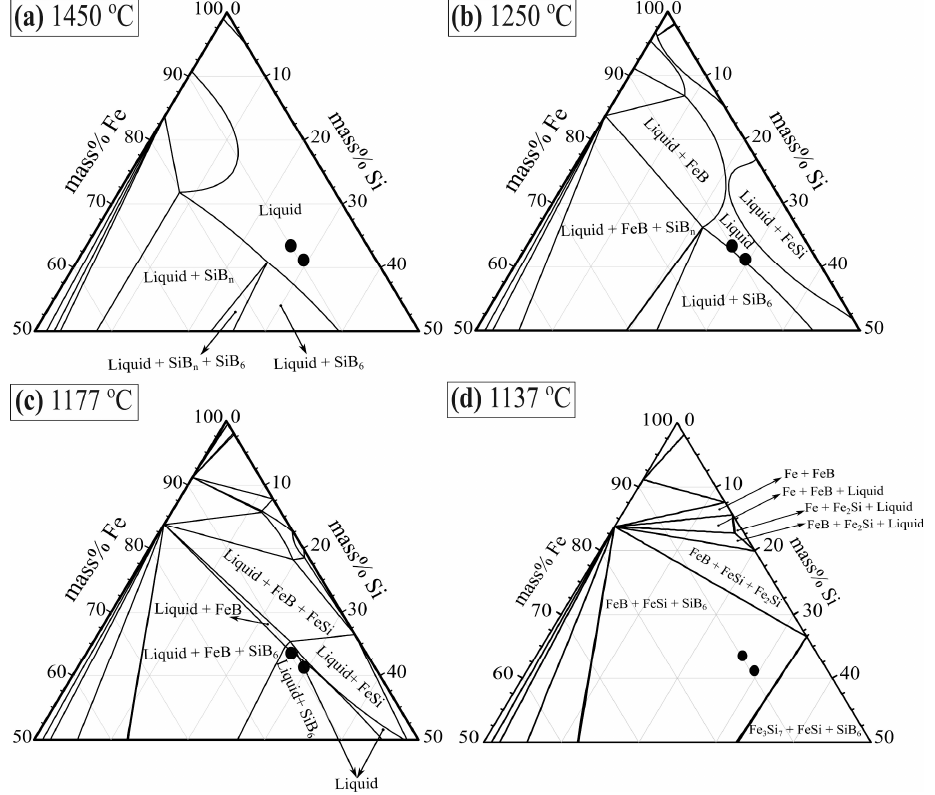
Figure 11. Isothermal cross-section of the ternary Fe-Si-B system at the iron range 50–100 mass % calculated by FactSage at temperatures of ( a ) 1450 °C, ( b ) 1250 °C, ( c ) 1177 °C, and ( d ) 1137 °C.